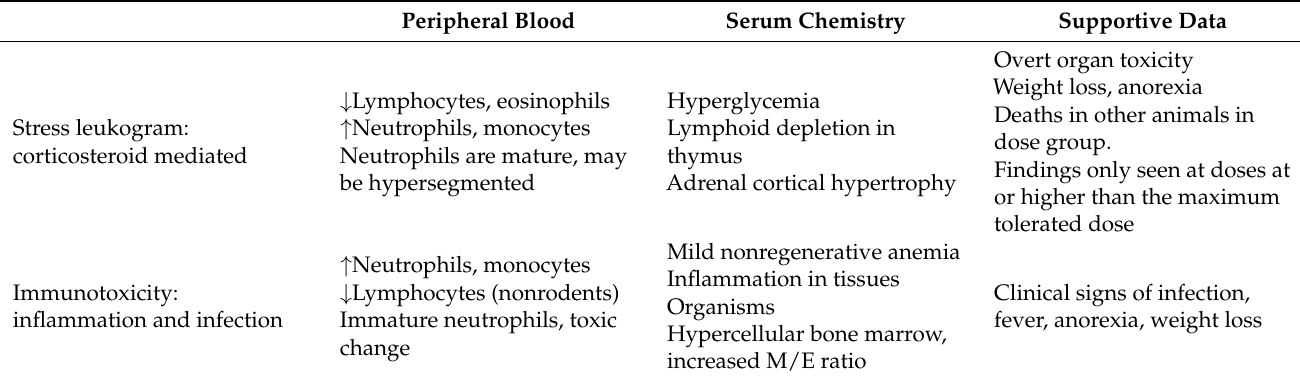
Table 2. Differentiating between stress and